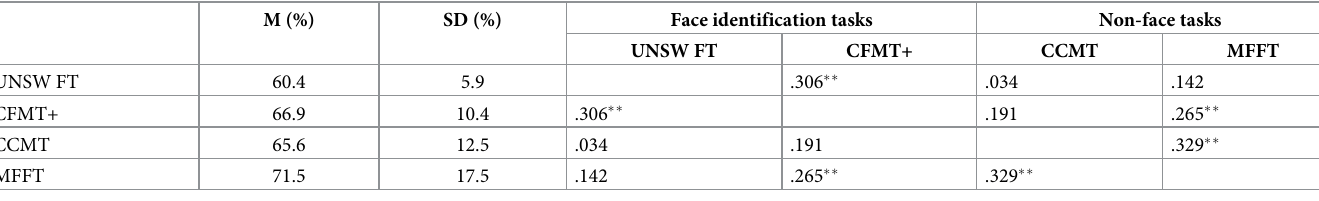
Table 3. Mean accuracy and correlation matrix for all tests in Lab Sample 2, demonstrating discriminant validity. M